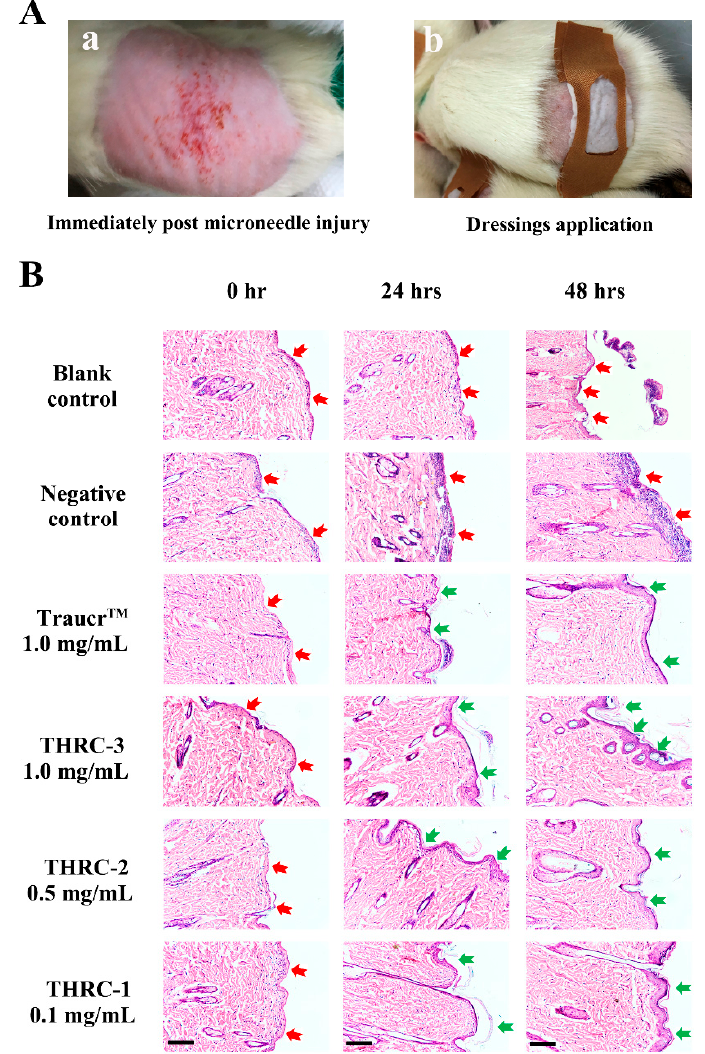
Figure 6. The microneedle-injured acute wound healing. ( A ) The experimental process. Immediately after microneedle injury, the epidermis of mice was destroyed with severe erythema ( a ). Subsequently, different dressings were applied with bandage fixation for 20 min ( b ). ( B ) H&E staining images of skin tissues of the blank control, the negative control, and the commercial control Traucr TM , THRC-3, THRC-2, and THRC-1 groups at different time intervals (0 h, 24 h, and 48 h). The damages of the epidermis were noted by red arrows, while accelerated healing of the epidermis was noted by green arrows. Scale bar: 100 μ m.